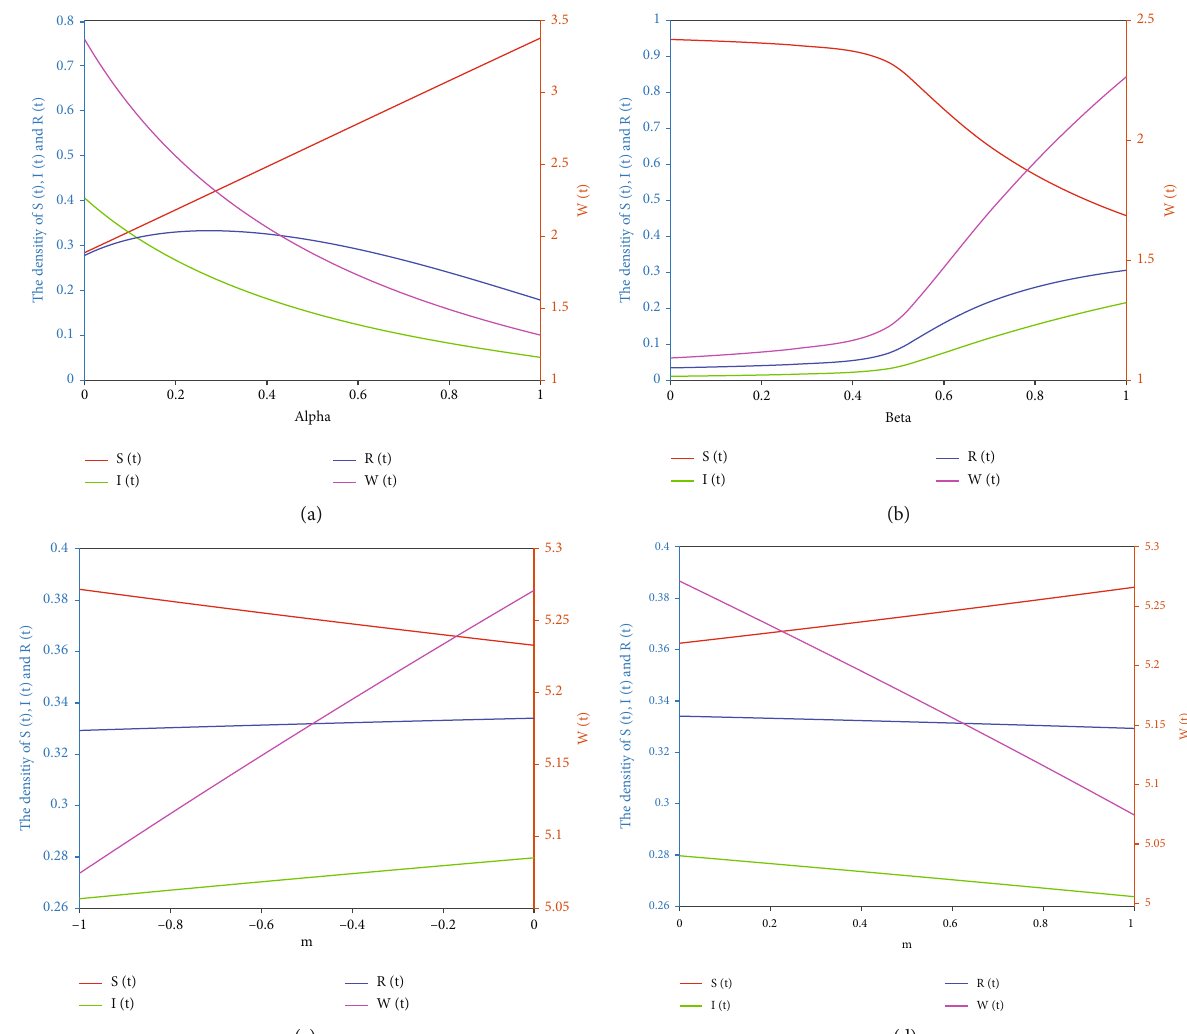
Figure 4: Density of S ð t Þ , I ð t Þ , R ð t Þ , and W ð t Þ under di ff erent parameters. (a) means density of S ð t Þ , I ð t Þ , R ð t Þ , and W ð t Þ under the parameter α ; (b) means density of S ð t Þ , I ð t Þ , R ð t Þ , and W ð t Þ under the parameter β ; (c) means density of S ð t Þ , I ð t Þ , R ð t Þ , and W ð t Þ under the parameter m < 0 ; and (d) means density of S ð t Þ , I ð t Þ , R ð t Þ , and W ð t Þ under the parameter m > 0